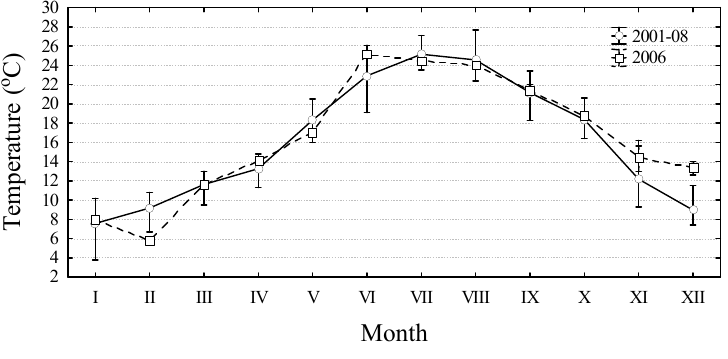
Figure 4. Mean monthly temperatures with the ranges during 2001 to 2008 period (excluding 2006) and in 2006 at central Adriatic Sea stations